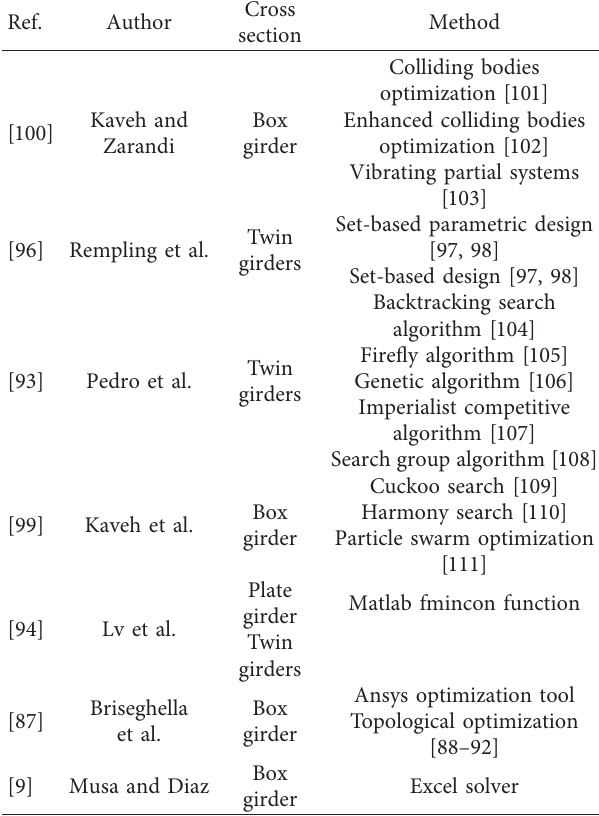
Table 2: Optimization techniques used by